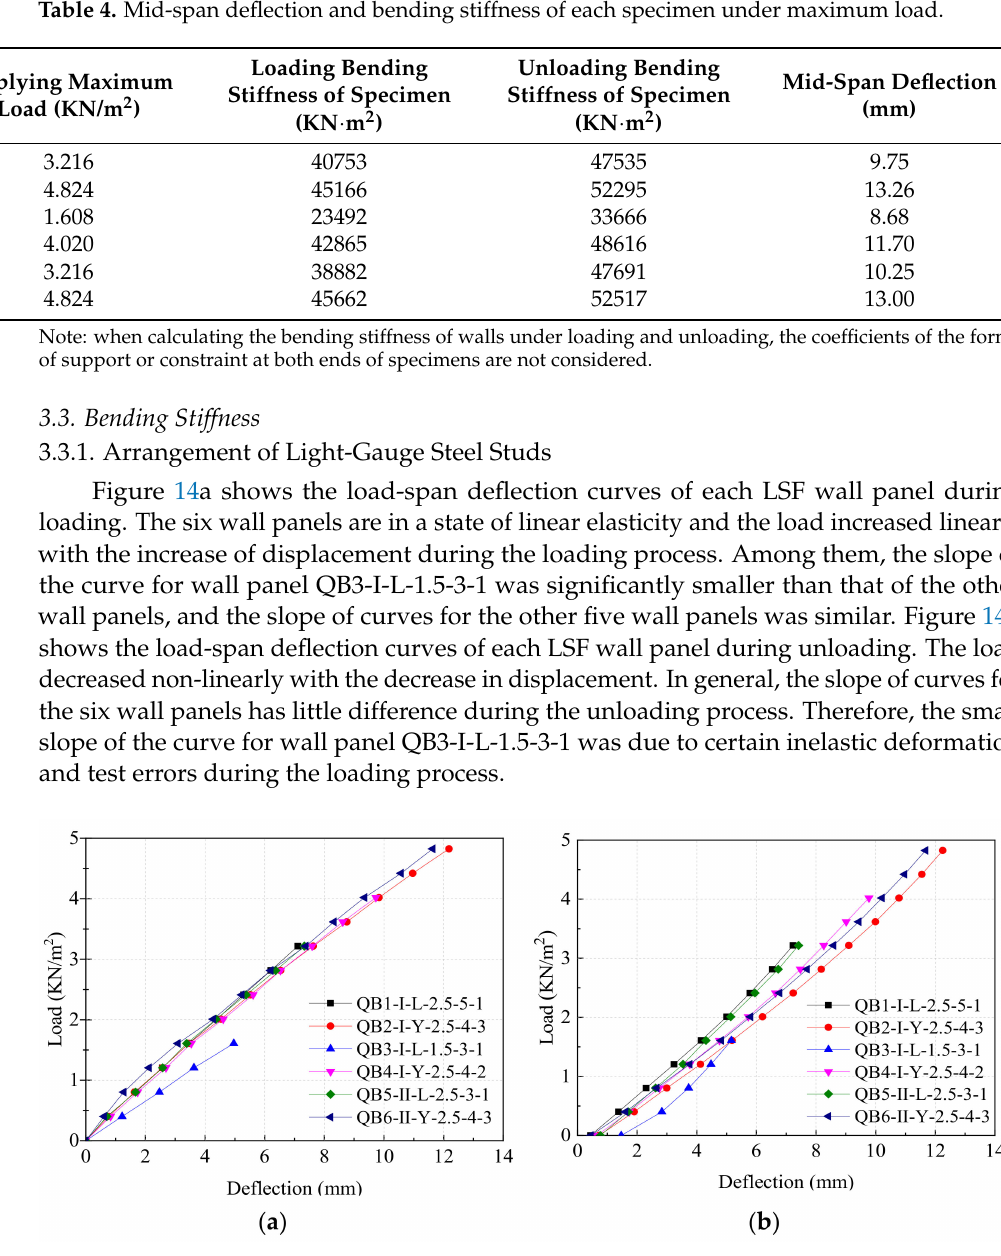
Figure 14. The mid-span deflection curves of LSF wall panels. ( a ) Loading; ( b )